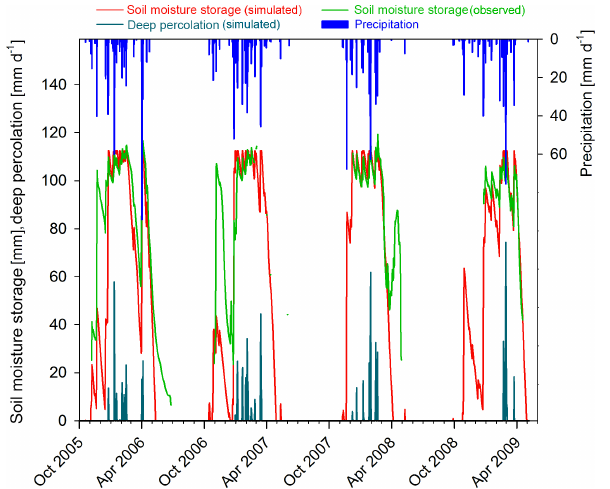
Figure 6. Comparison of observed and modelled available soil moisture at Ras Karkar West (RK-W) from 2005–2006 to 2008– 2009. Maximum water storage capacity ( θ s ; at 112.5mm) of the modelled moisture level (red) matched well with the observed max- imum moisture (green). Brief periods of dashed green lines show questionable and erroneous soil moisture readings (see also Sect. 5 and Appendix B). Deep percolation (triggered above θ s ) is indi- cated as a dark-blue column (bottom of the graph); daily rainfall is indicated as blue columns (at the